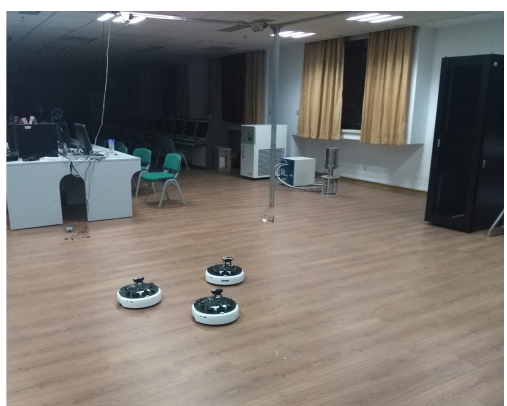
Figure 7. Experimental